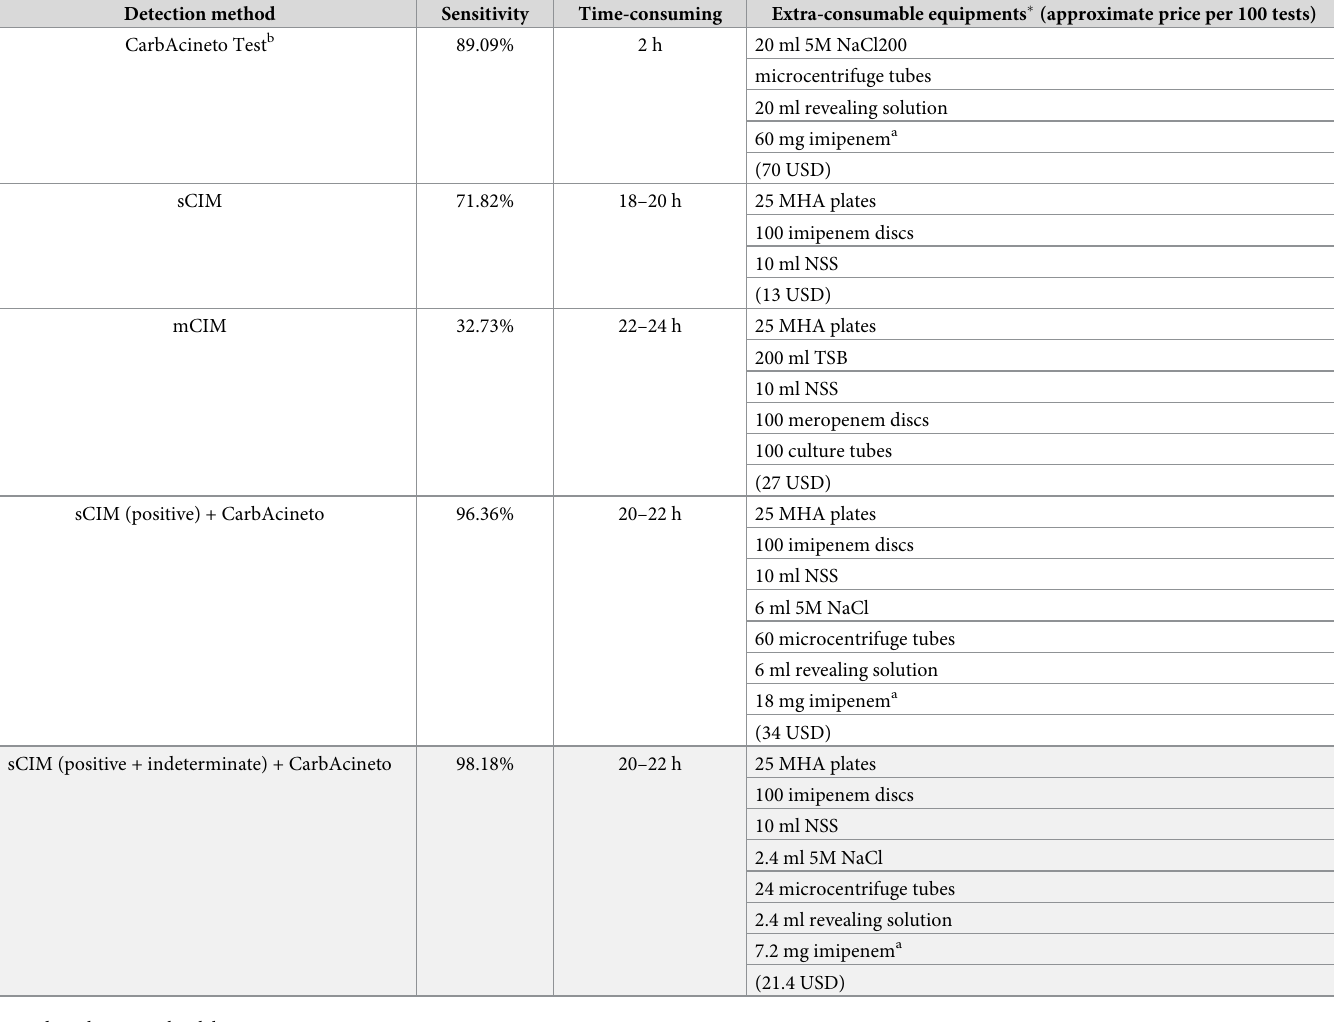
Table 3. Comparison of phenotypic methods for early detection of carbapenemase-producing A . baumannii